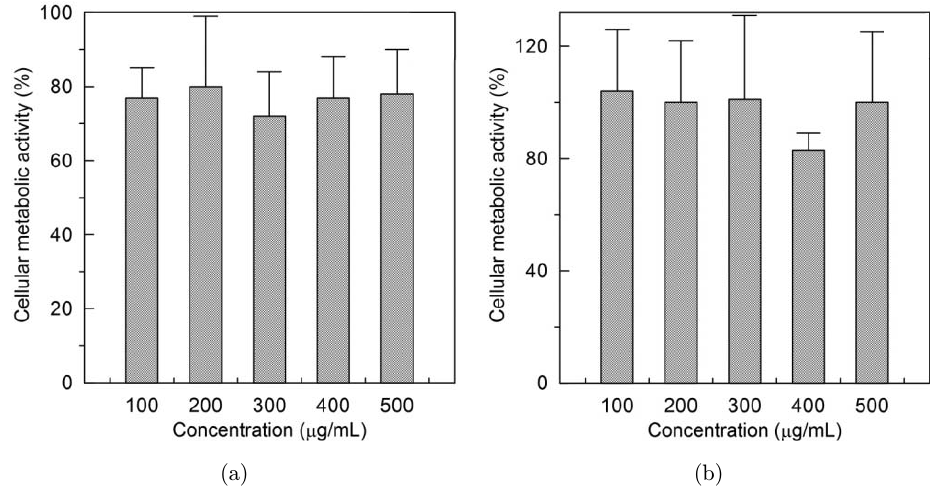
Fig. 3. Viability of the SPEV (a,b) and A549 (c,d) cells after exposure to di®erent concentrations of NC-loaded protein nano- particles (a,c) and Au – HSA NCs (b,d). Viability was determined by the MTT assay. The error bar represents the standard error of eight